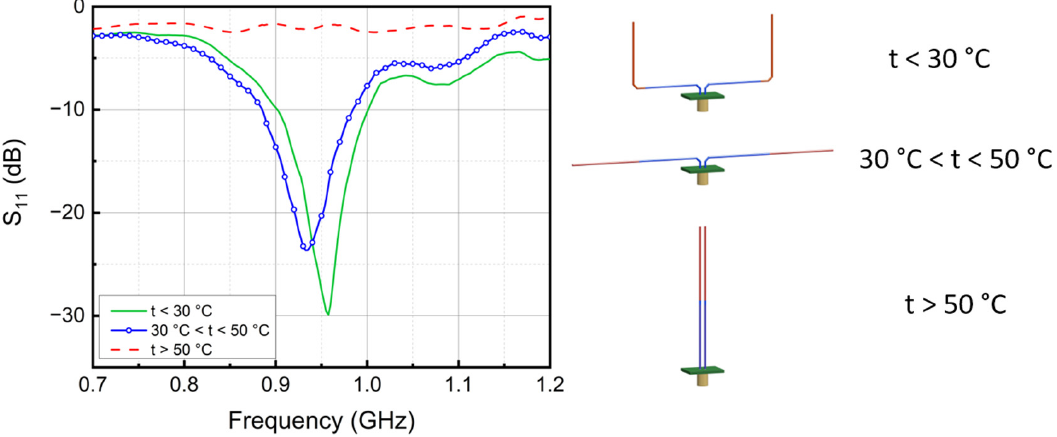
Figure 8. Measured frequency response of the ShMoA and its corresponding shape at different temperatures.